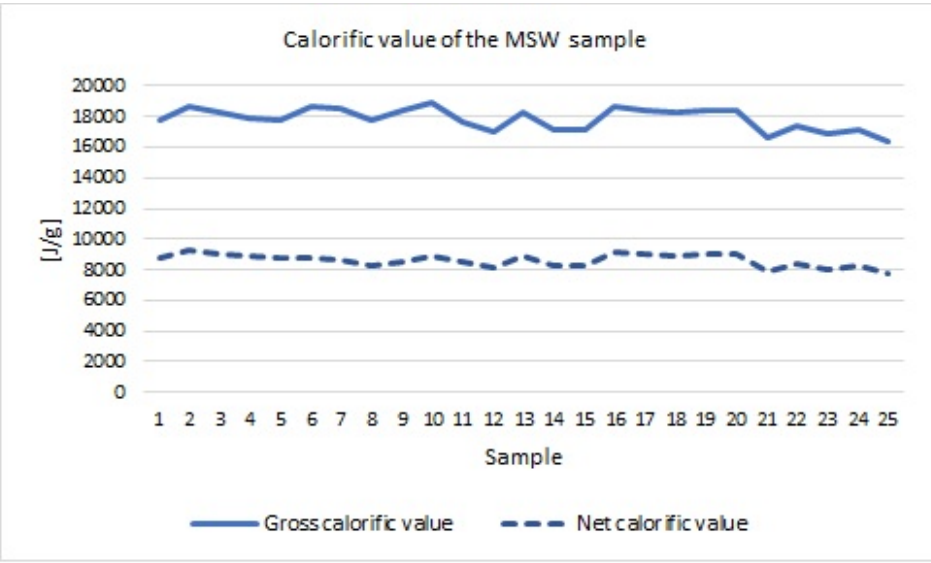
Figure 5. Variation of gross calorific value (GCV) and net calorific value (NCV).